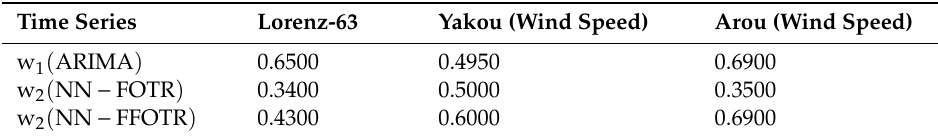
Table 1. Single-model weights.